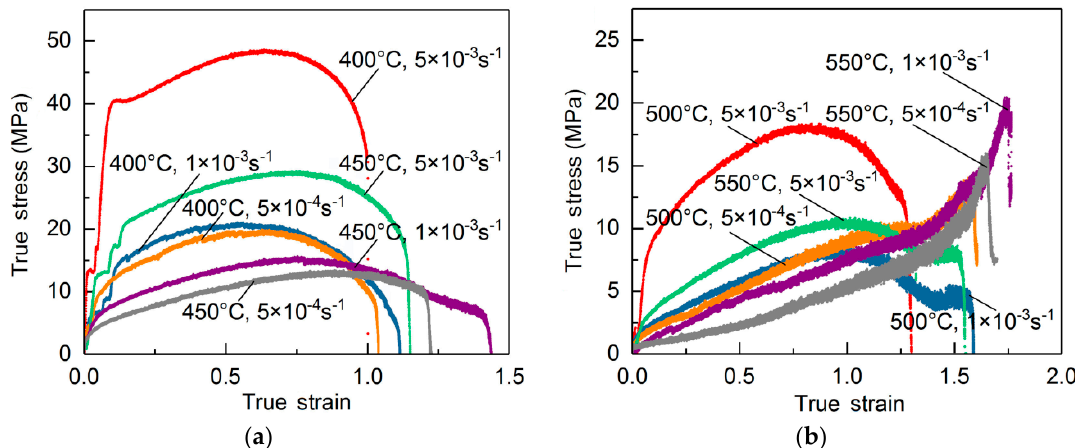
Figure 4. True strain-true stress results for the fine-grained 5A70 alloy at different temperatures: 400–450 °C ( a ) and 500–550 °C ( b ) with strain rates: 5 × 10 − 3 –5 × 10 − 4 s − 1 .